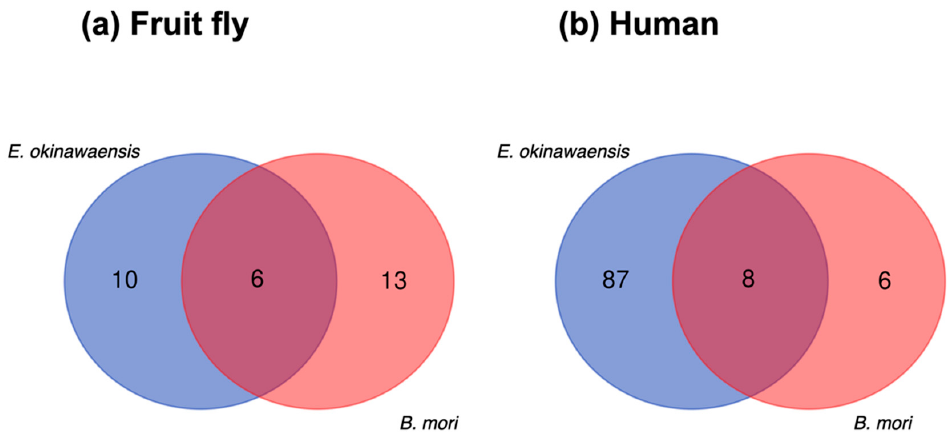
Figure 4. Comparison of ncRNA transcripts between E. okinawaensis and B. mori. ( a ) The numbers of ncRNA transcripts predicted from fruit fly annotation. ( b ) The numbers of ncRNA transcripts predicted from human annotation.